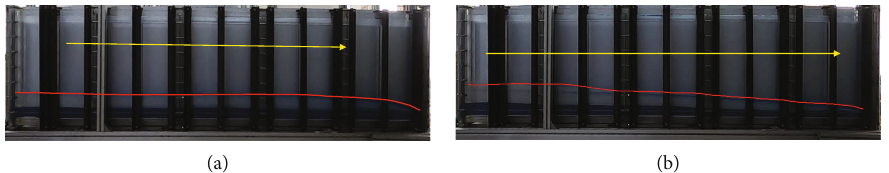
Figure 4: Layout diagram of sand dune with di ff erent displacement rates: (a) displacement rate of 4.5m 3 /min and (b) displacement rate of 3m 3